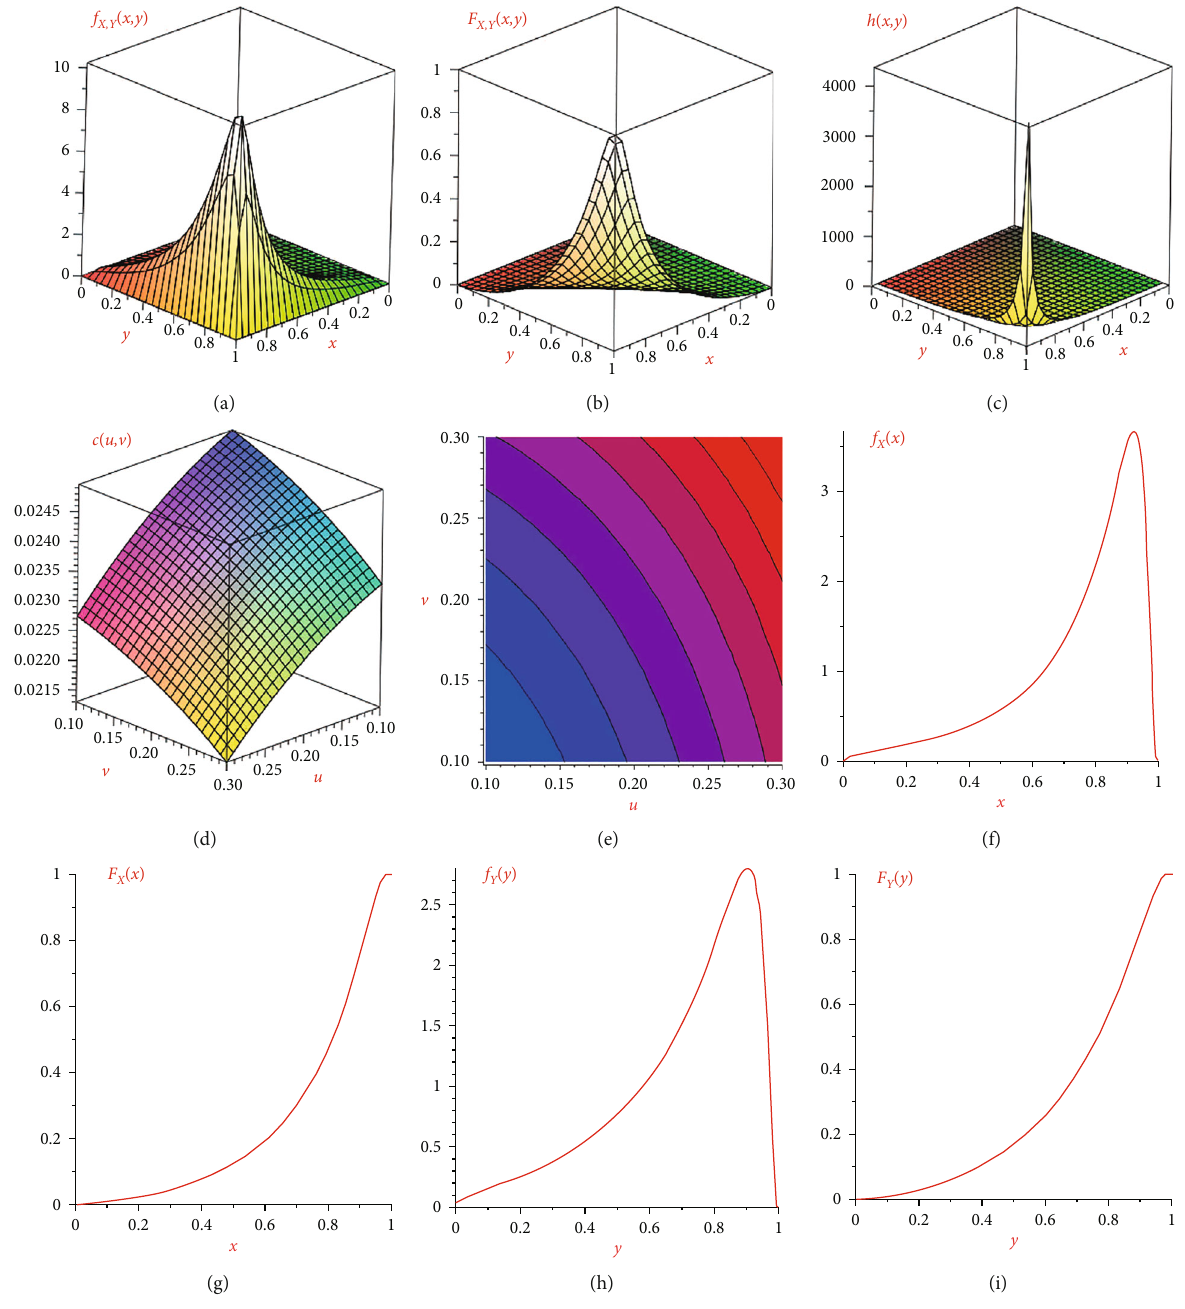
Figure 16: Statistical quantities for ð X , Y Þ ~ BIUPW ð 0 : 8,0 : 4,1 : 5, − 0 : 8, − 0 : 4,0 : 7 Þ